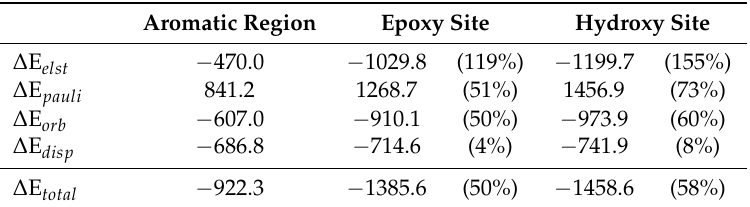
Table 3. Partition of the total energy for the interaction of CP adsorbed on circumcoronene-based prototypes (see Figure 1), as predicted by the EDA scheme. The energies were computed for the most stable complex structure. In parentheses the percent increase of the partial energy with respect to the aromatic region prediction is also shown. All values are in meV (1 kcal/mol = 43.37 meV) and are not corrected for the